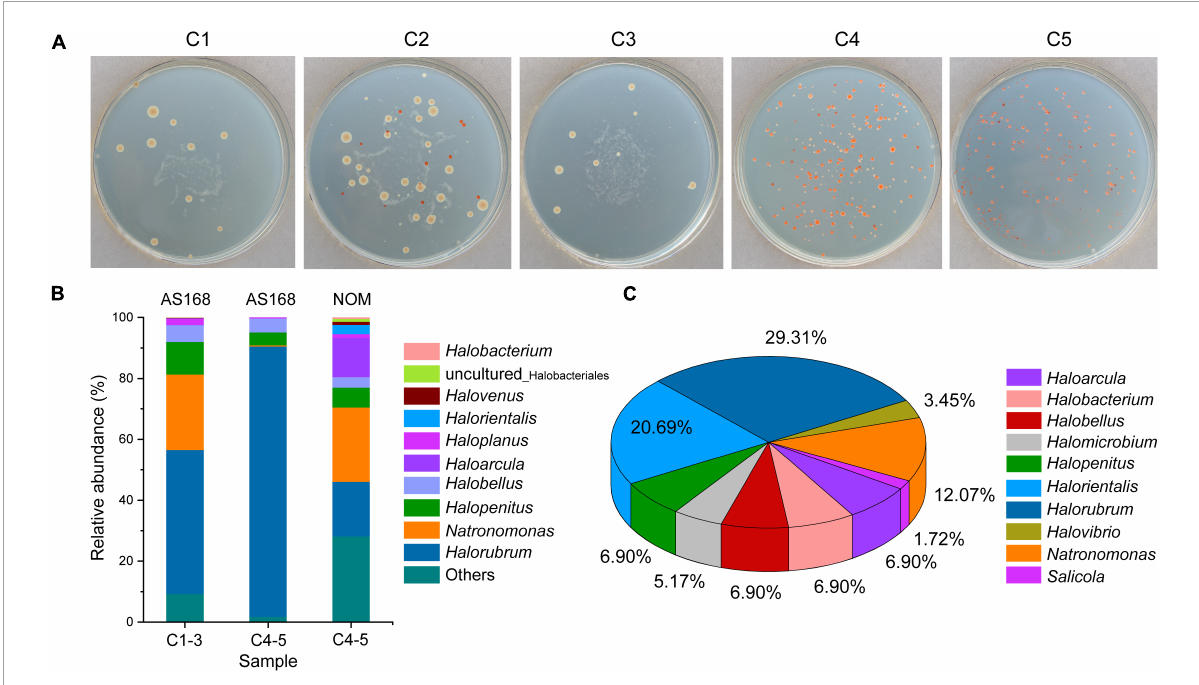
FIGURE6 Halophilic archaea and halotolerant bacteria isolated from brine samples. Cultivation of halophilic microbes from brine samples using the AS-168 agar plates (A) . Cultures grown on the AS-168 and NOM agar plates were collected by washing with 20% (w/v) sterilized NaCl solution for archaeal 16S rRNA gene (V3 + V4) high-throughput sequencing (B) . Microbial composition of randomly isolated strains identified by sequencing the almost complete 16S rRNA gene combined with sequence similarity search (C) . C1-3, three brine samples including C1, C2, and C3 collected in July 2021; C4-5, two brine samples including C4 and C5 collected in August